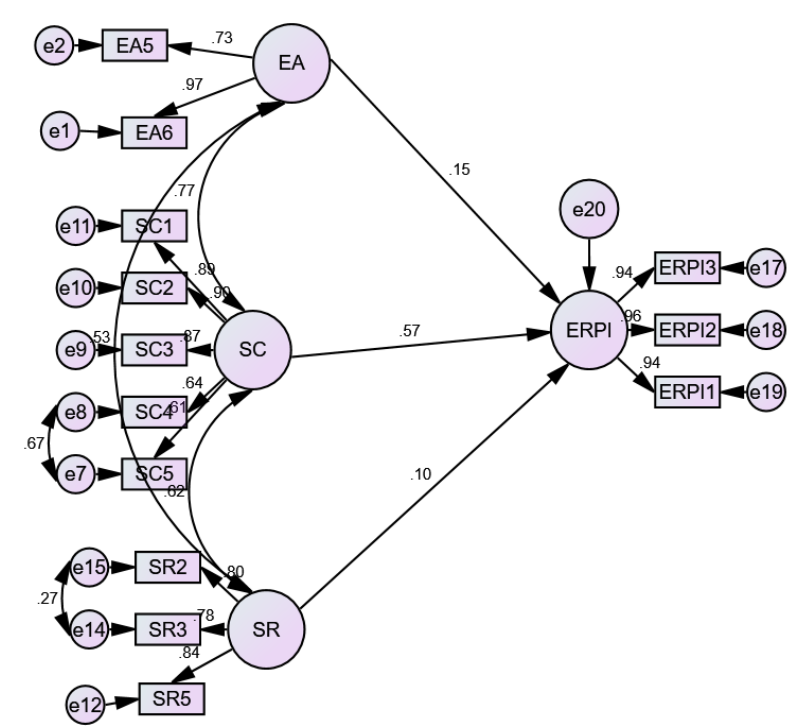
Figure 2. Structural model.